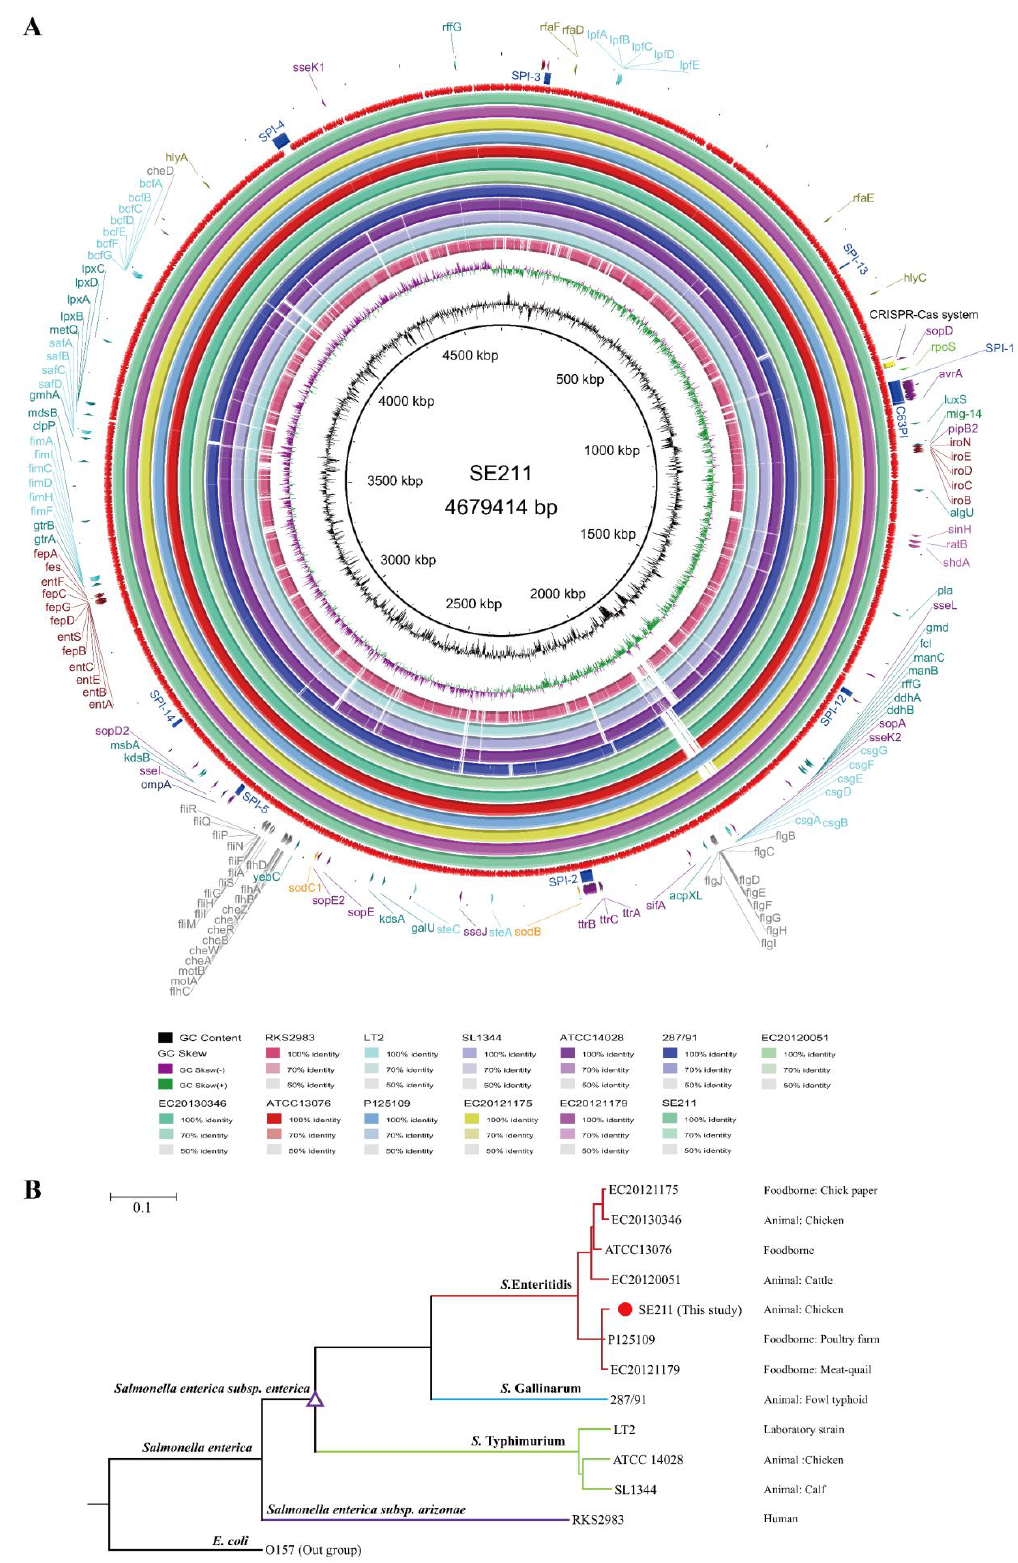
Figure 3. Genome comparisons and hierarchical clustering of twelve Salmonella enterica chromosomes. ( A ) Comparison